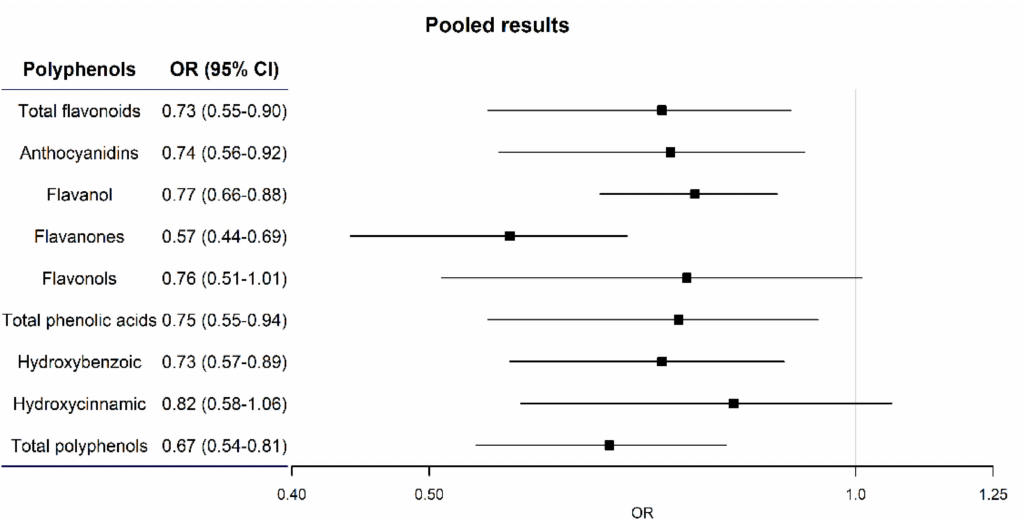
Figure 2. Pooled OR and 95% CI of selected polyphenols intake.